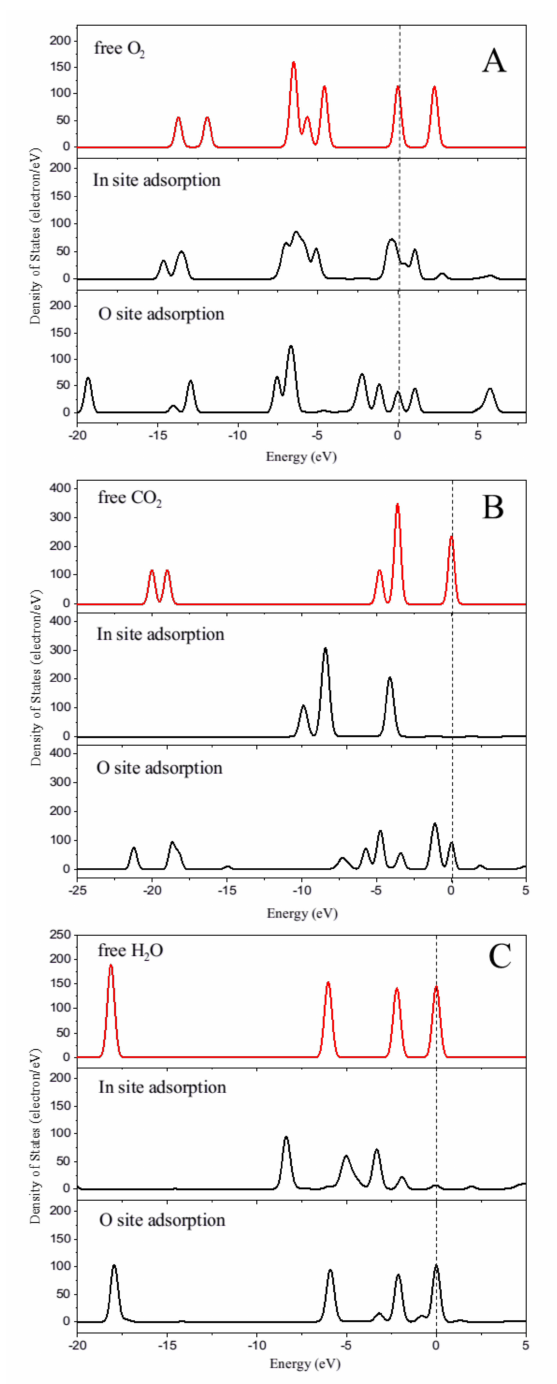
Figure 8. The PDOS before and after O 2 ( A ), CO 2 ( B ), and H 2 O ( C ) adsorption on In and O site of